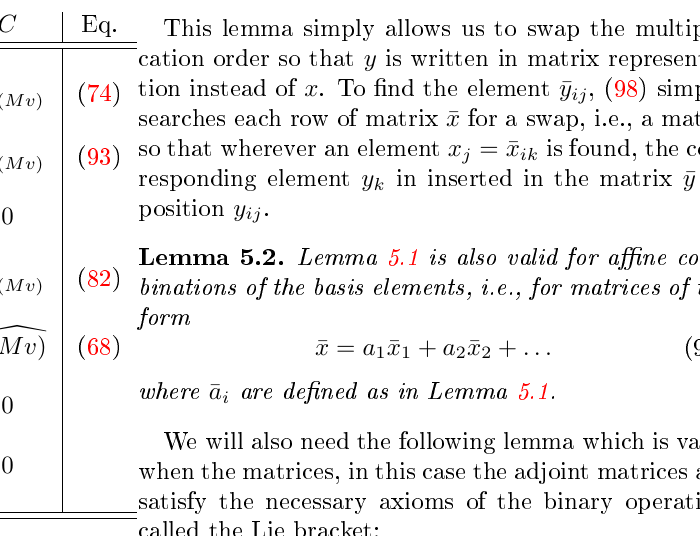
Table 2: The velocity transformation matrices S ( ϕ ) and the corresponding Coriolis matrices for di(cid:27)erent Lie subgroups of SE (3) . The ex- plicit expressions for the di(cid:27)erent Lie groups are found in the equations in the right-most